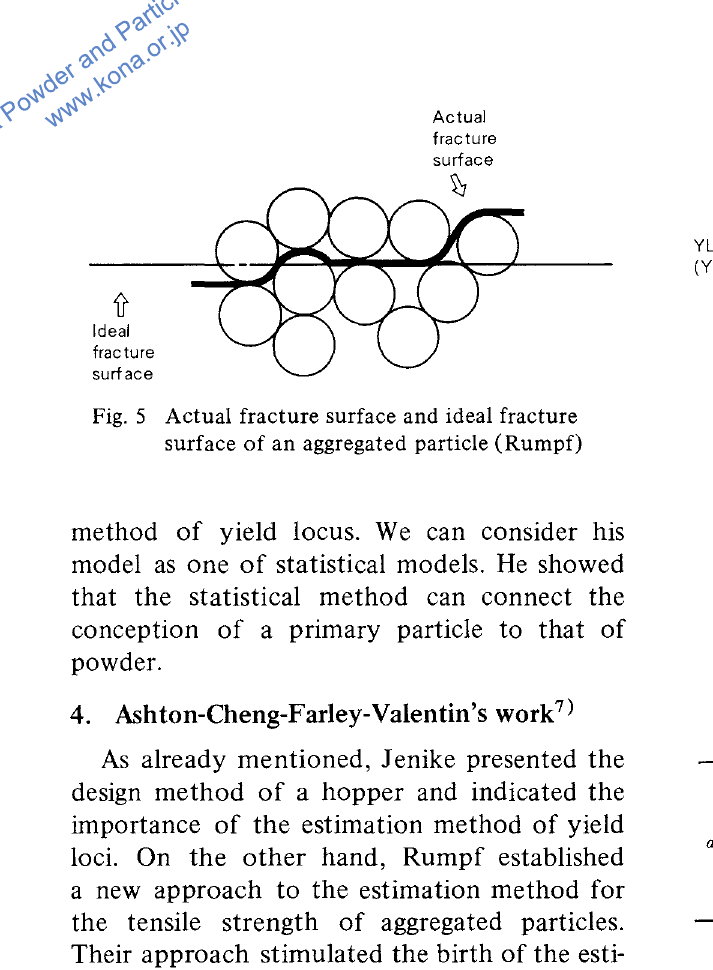
Fig. 6 YL, CYL and CSL in (a, T, e) system